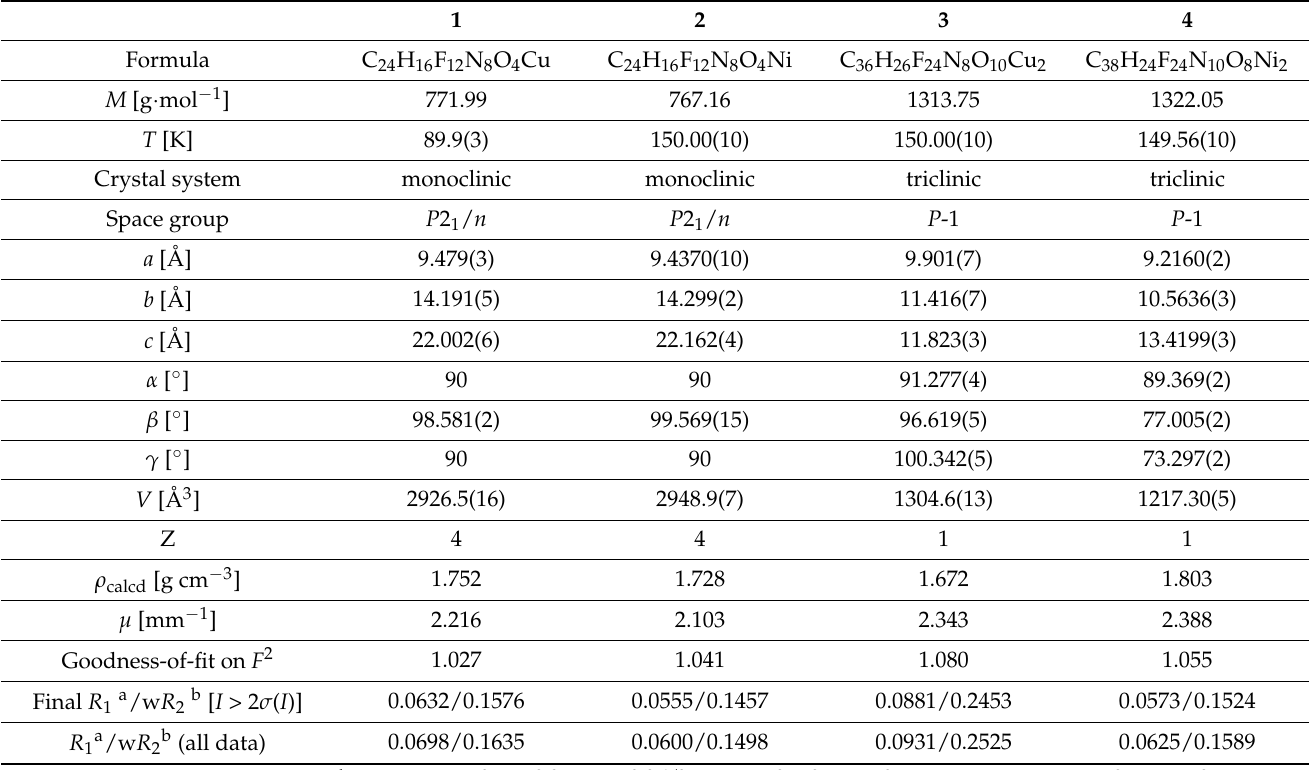
Table 1. Crystallographic data, details of data collection and structure refinement parameters for compounds 1 – 4